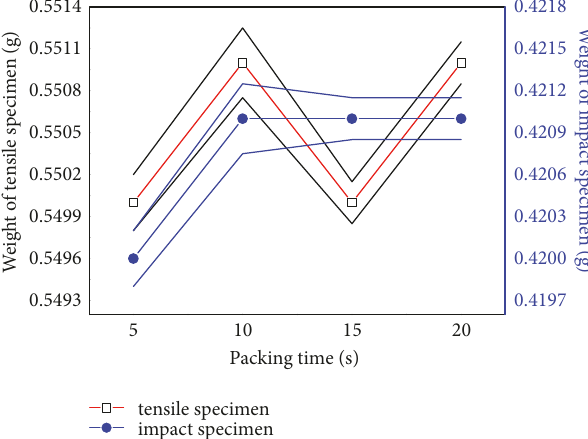
Figure 7: Influence of packing time on product